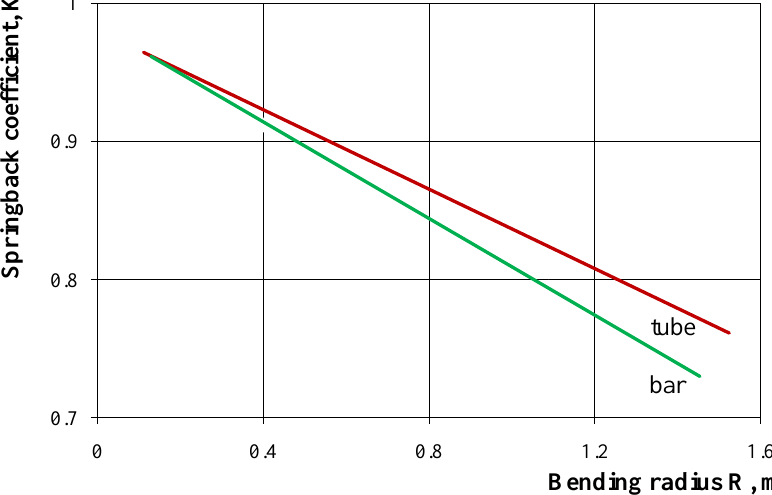
Figure 7. Comparison of the springback characteristics of a square tube with the dimensions of 21.5 × 21.5 × 1.8 mm and a bar with the dimensions of 21.5 × 21.5 mm determined on the basis of numerical modeling.